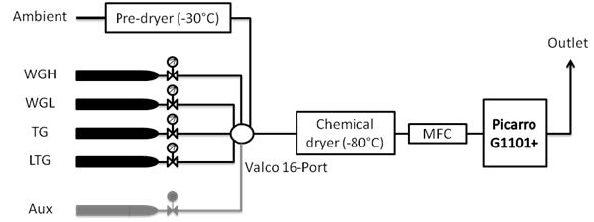
Fig. 1. Schematic setup of the in situ 13 CO 2 monitoring system: the working gases high (WGH) and low (WGL) as well as the target gases (TG and LTG) and the pre-dried ambient air are connected to a rotary valve. After this all gases share the same path through a chemical dryer (Mg[ClO 4 ] 2 ) and an external mass-flow controller (MFC) before entering the cavity ring-down